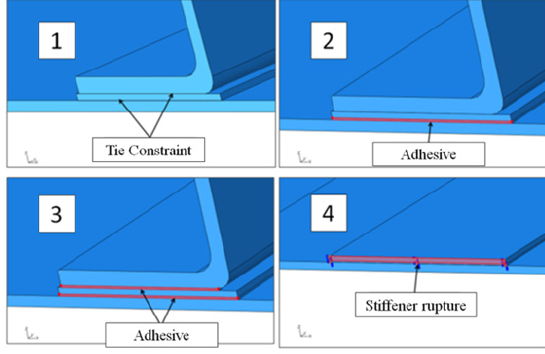
Table 2: FE models developed in this work.